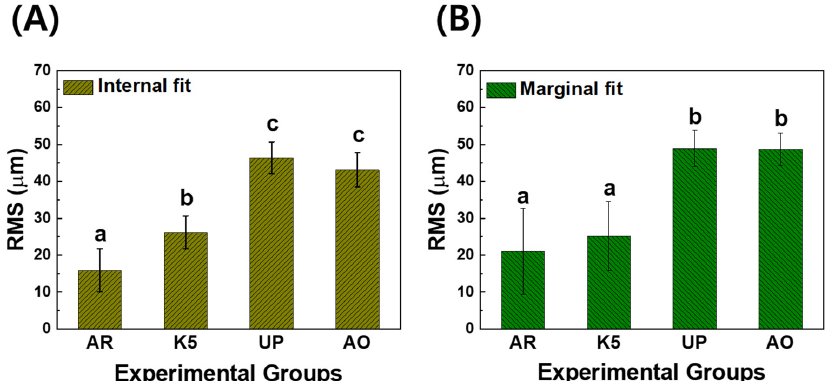
Figure 3. RMS values of ( A ) the internal fit and ( B ) the marginal fit of the zirconia specimens